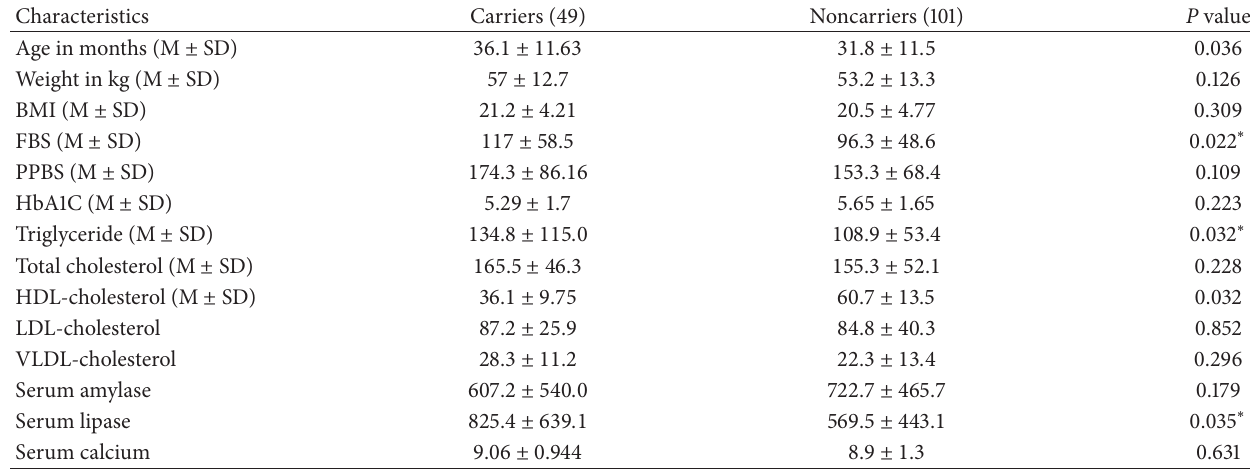
Table 4: Demographic and clinical profile of 150 chronic pancreatitis cases (carriers versus noncarriers) screened for CFTR